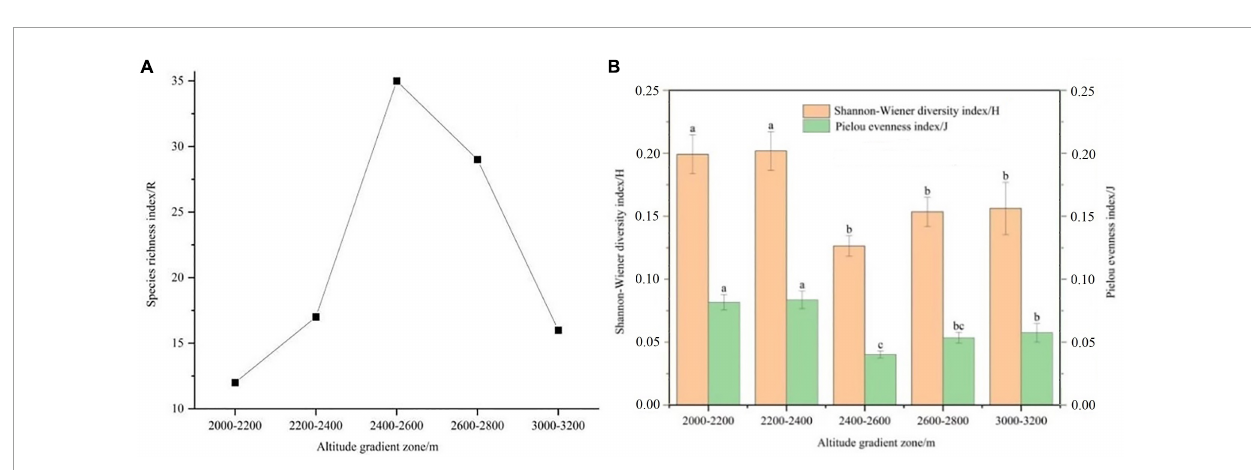
FIGURE5 α diversity index of herbaceous plants in different altitude gradients of sunny slope. (A) Species richness index, and (B) Shannon-Wiener diversity index and Pielou evenness index. Different lower case letters in the figure indicate that there are significant differences between different altitude gradients ( P <